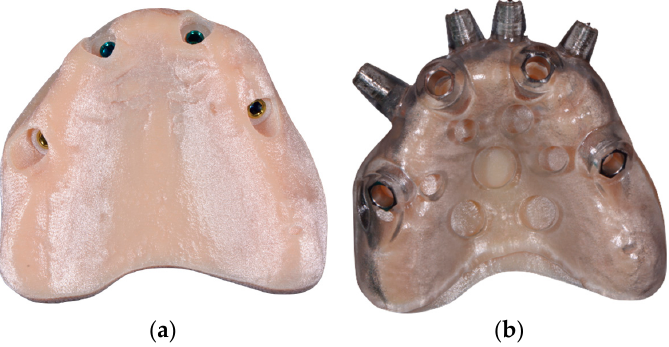
Figure 7. ( a ) Stereolithographic model with analogs. ( b ) Surgical